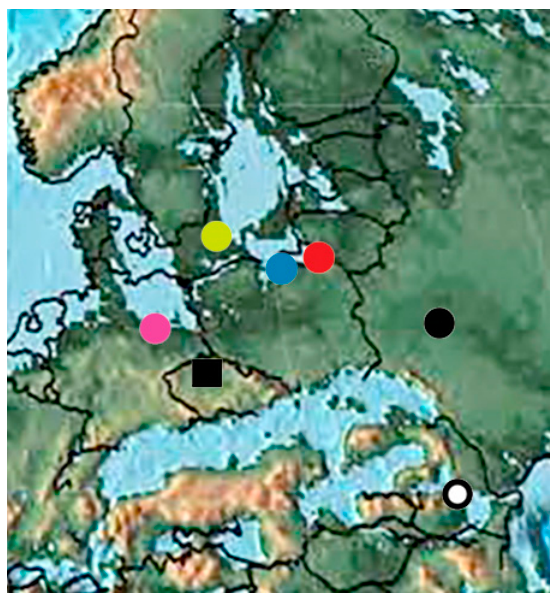
Figure 12. Bartonian Curculionoidea deposits: red circle—Baltic amber (Kaliningrad region); blue circle—Polish amber; yellow circle—Scandinavian amber; pink circle—Bitterfeld amber; ring—Romanian amber; circle—Rovno amber; square—Kutschlin. Geosciences 2019 , 9 , x FOR PEER REVIEW 34 of 50